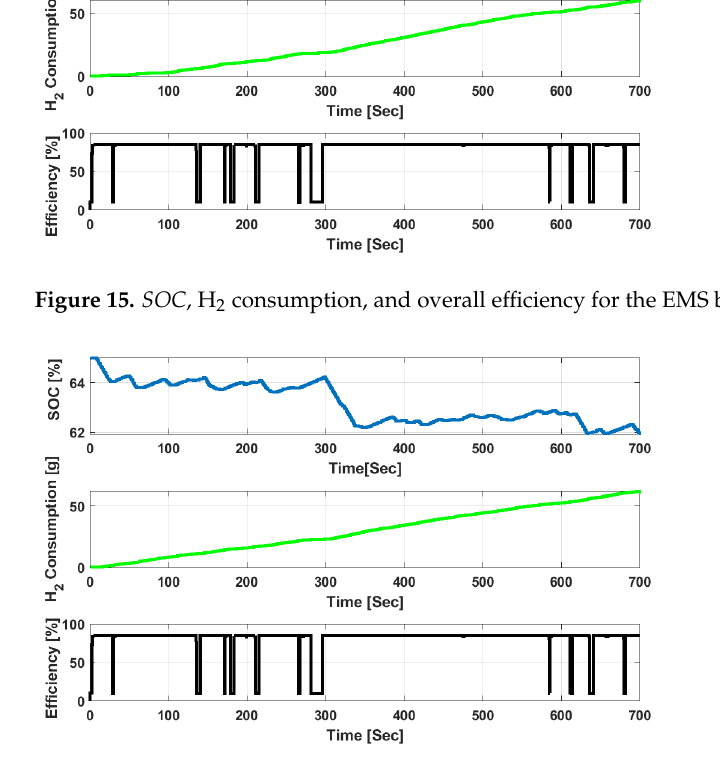
Figure 16. SOC , H 2 consumption, and overall efficiency for the EMS based on